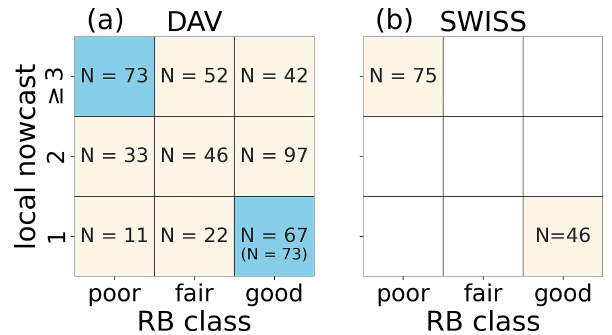
Figure 4. Classification of profiles for (a) the DAV data set and (b) the SWISS data set into RB stability – local nowcast classes. The numbers in the boxes denote the number of profile pairs per class which fulfilled the similarity criteria. The profiles in the blue boxes were used for the training of the classification model, while the beige boxes were used for model evaluation. The second num- ber in the lower-right class, N = 73, indicates that we included six additional layers of the stable profiles with RB score 7 to obtain a balanced training data